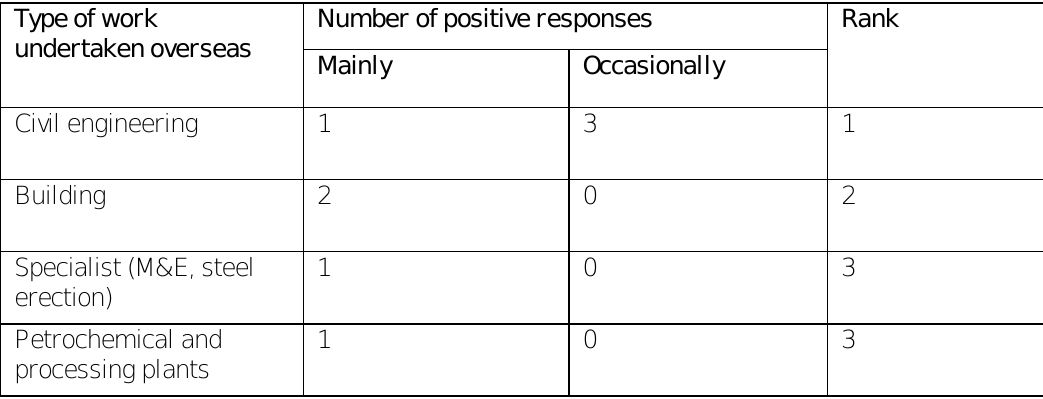
Table 4: Type work undertaken overseas